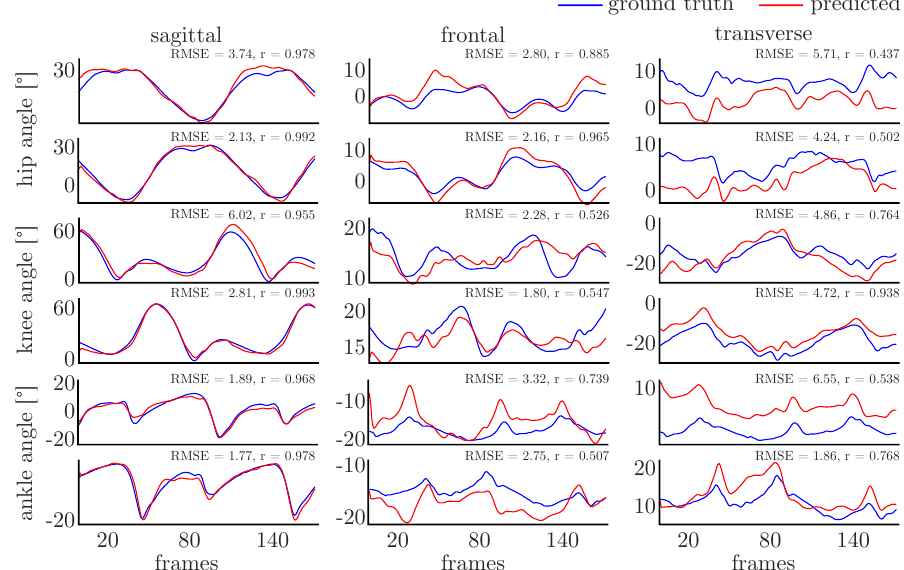
Figure 7. A single example of the joint angle prediction using PS-net . The joint angles predicted for the right are displayed on top of those predicted for the left. The sample depicts the one with the median RMSE